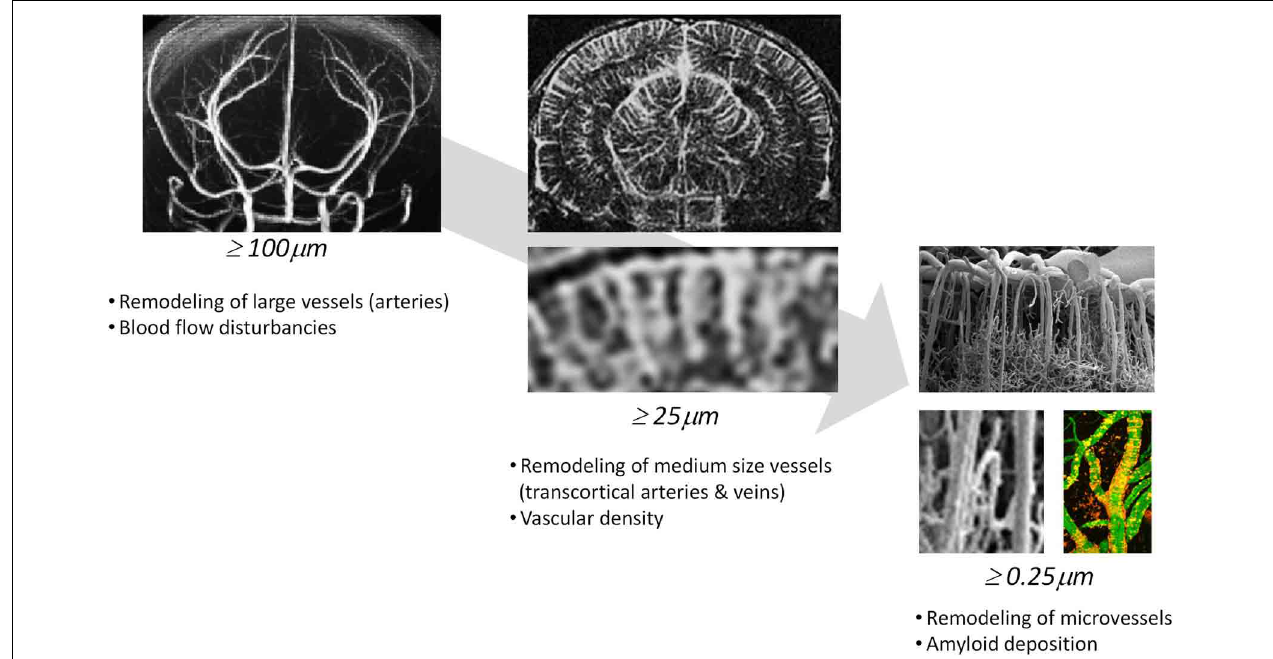
FIGURE 1 | Phenotypic characterization of cerebrovascular structures at various length scales. Time-of-flight magnetic resonance angiography can depict large vessels ( ≥ 100 μ m ), contrast-enhanced